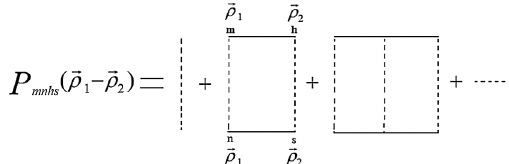
randomness two-dimensional Green’s function of the surface